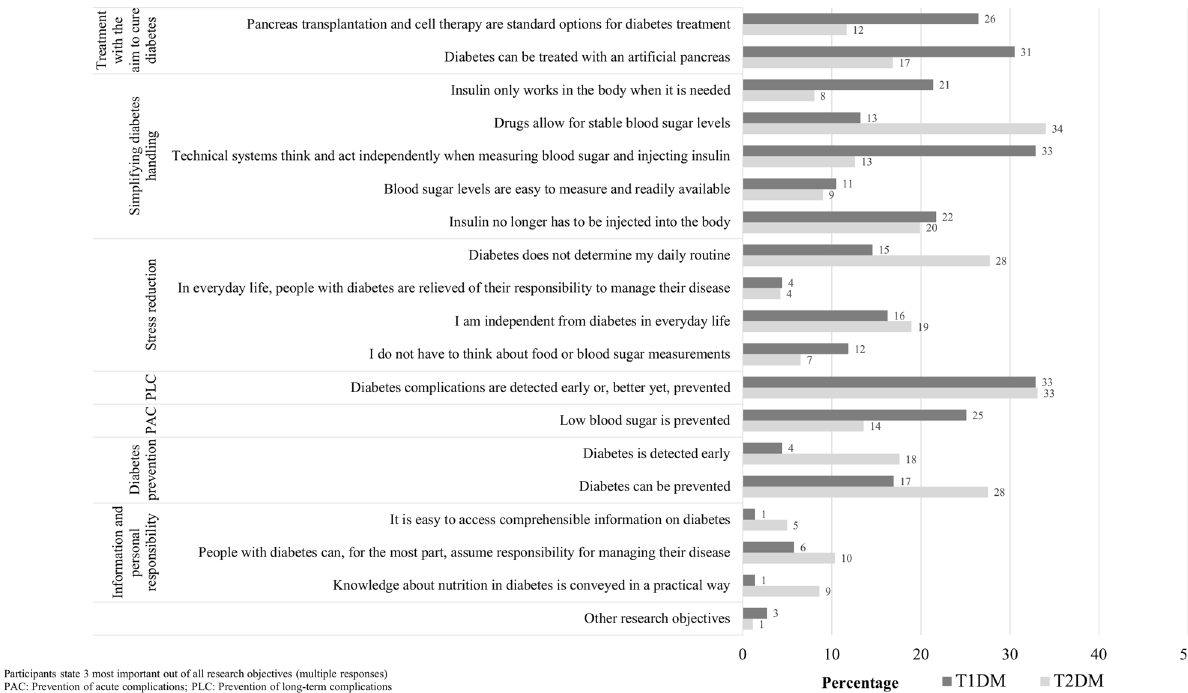
Figure 2. Priorities of people with T1DM (n = 295) and T2DM (n = 523) regarding future diabetes-related research objectives.